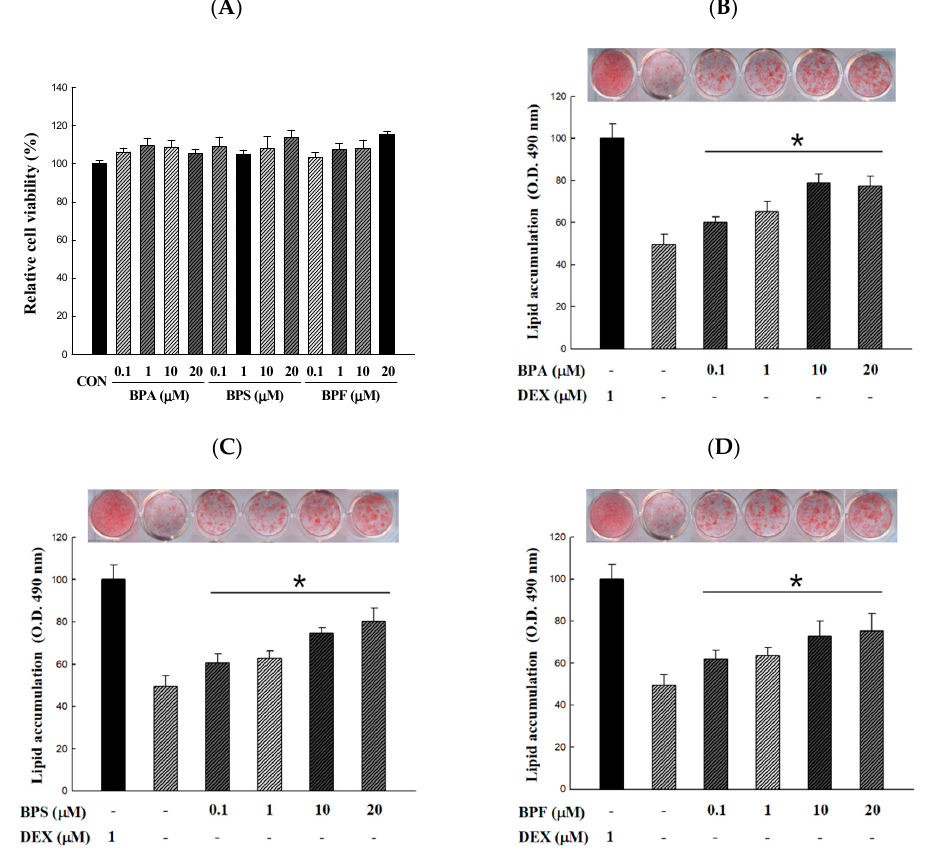
Figure 2. Cell viability and lipid accumulation from Bisphenol A (BPA), Bisphenol S (BPS), and Bisphenol F (BPF)-induced 3T3-L1 adipocyte. 3T3-L1 adipocytes were differentiated for 10 days with Bisphenol F (BPF)-induced 3T3-L1 adipocyte. 3T3-L1 adipocytes were di ff erentiated for 10 days